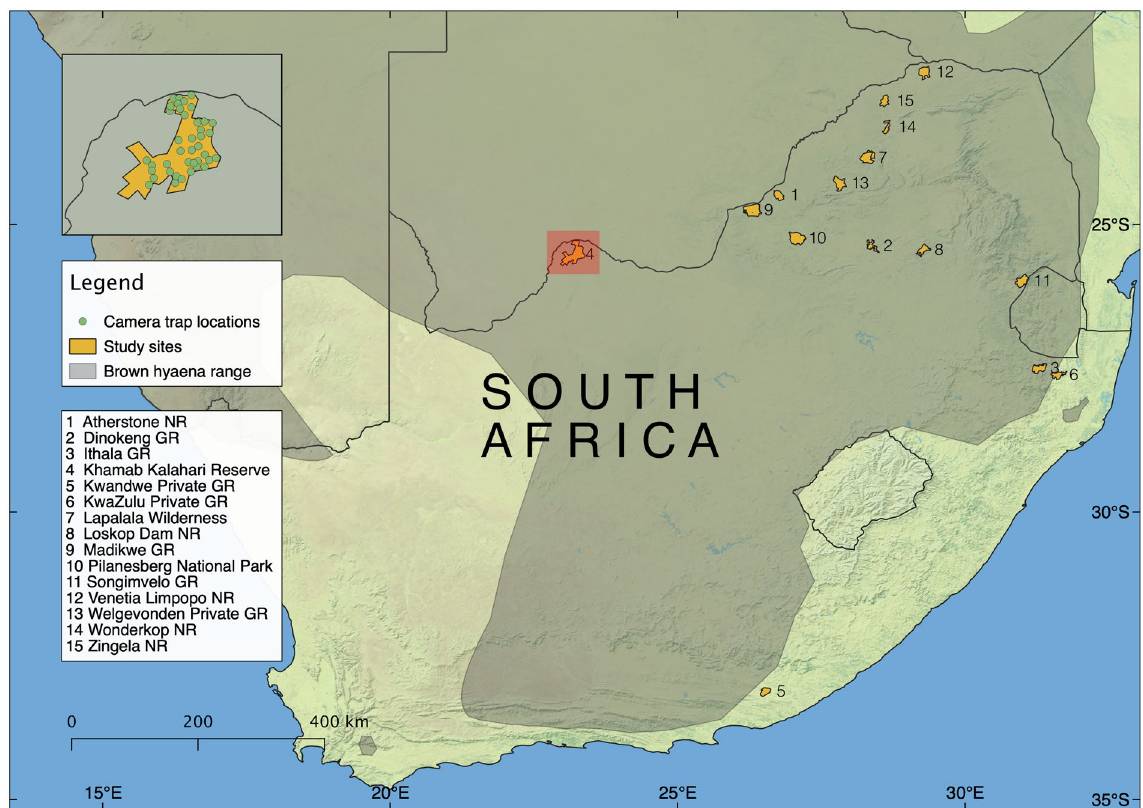
Figure 1. Map showing the locations of the survey sites where brown hyaena population densities were estimated. Inset map shows an example layout of a camera trap array at Khamab Kalahari Reserve. In the legend NR refers to Nature Reserve, and GR refers to Game Reserve. Created using QGIS 3.10.10 30 , using hyaena range data from 28 and base map data from 31 .